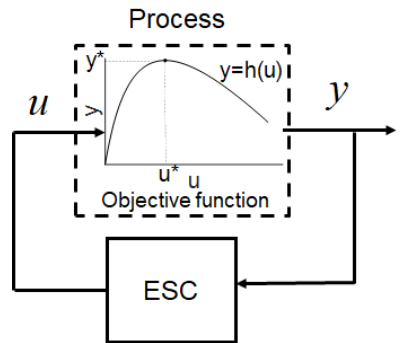
Figure 1. Extremum seeking control (ESC) basic